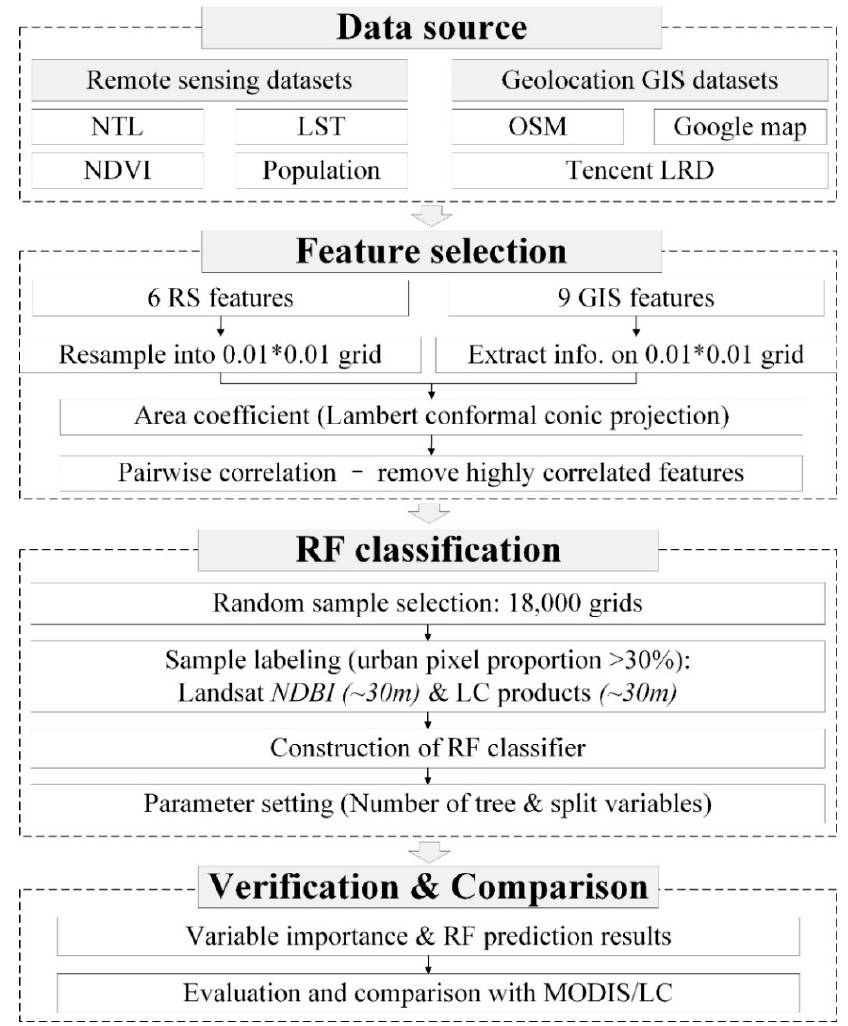
Figure 2. The workflow of urban area extraction based on the random forest (RF) classifier.